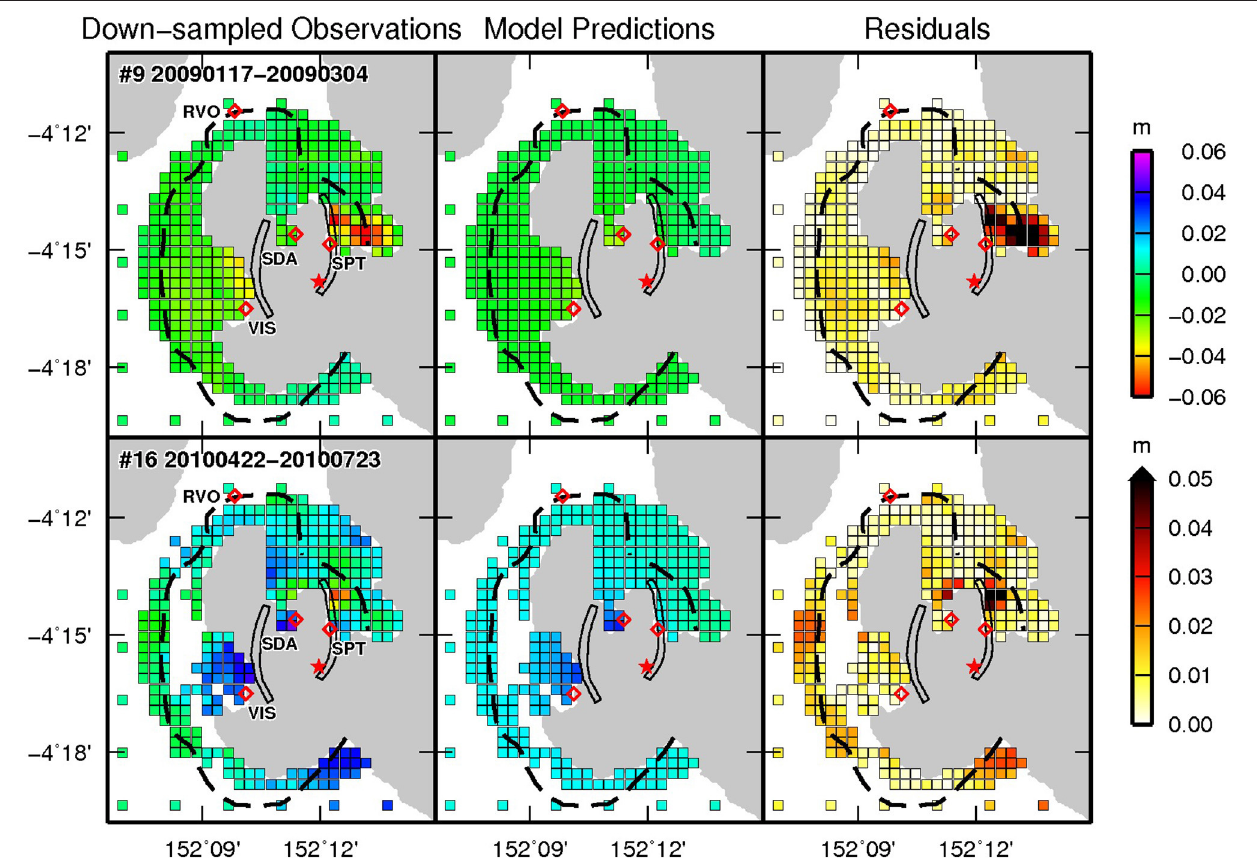
FIGURE 10 | Examples of InSAR down-sampled observations, model predictions, and residuals from the joint time series inversion (Step 2). Interferogram #9 corresponds to the time of caldera subsidence (negative signal), whilst interferogram #16 corresponds to the time of caldera uplift (positive signal). Both interferograms contain large spatially-correlated signals not directly related to the deformation of the shallow magma body. Red star shows the location of the best fitting Mogi source determined from the joint inversion grid search. Red labelled diamonds indicate the location of the four GNSS stations. Corresponding data for all 20 interferograms are shown in Supplementary Figure 1 . Black dashed line indicates the general topographic rim of the nested caldera complex and the black polygons outline the two zones of concentrated seismicity (described in Figure 2